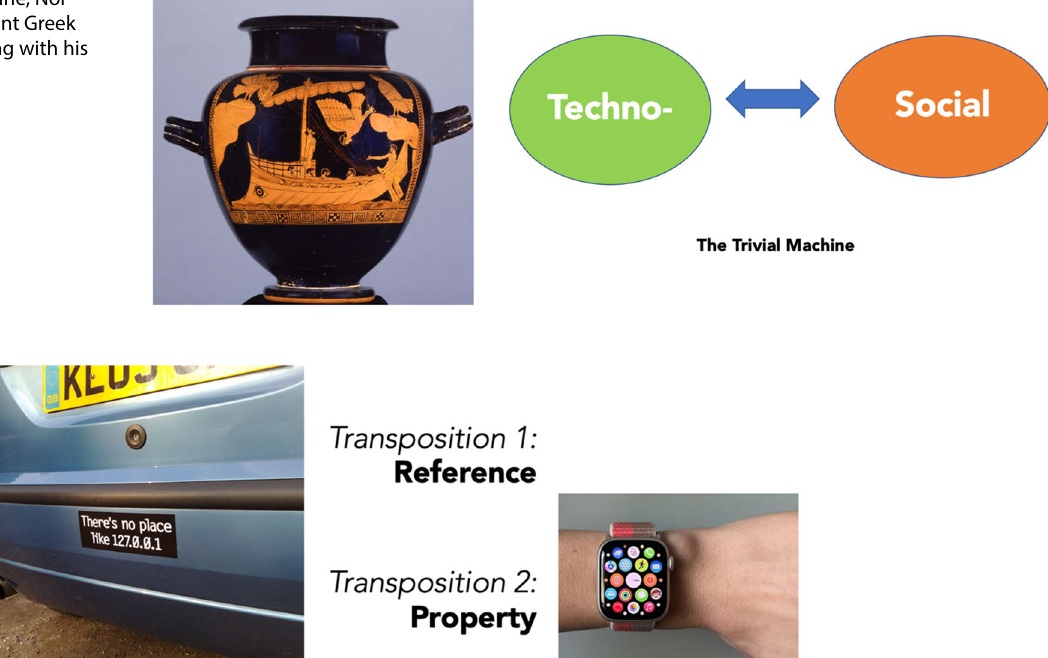
Fig. 5 A trivial machine, Nor- bert’s Weiner’s Ancient Greek Steersman interacting with his pair of steering oars